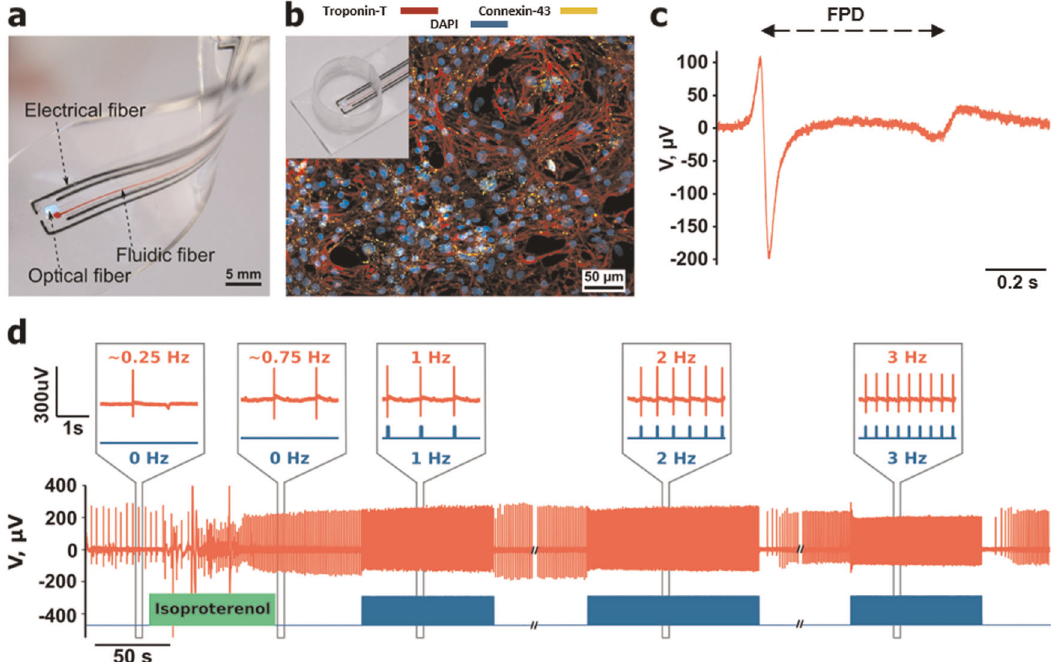
Fig. 4 Printed membrane for cardiomyocyte interfacing. a Integrated array of functional fi bres where active sites form four electrodes, an optrode and a chemotrode. b hiPSC-derived cardiomyocytes cultured on the array express key cardiomyocyte markers troponin-T (red) and connexin-43 (yellow). Nuclei are labelled with DAPI stain (blue). Scale bar 50 μ m. Inset: membrane equipped with printed culture chamber. c Recording of spontaneous electrical activity ( fi eld potential) from hiPSC-CM. The waveform shows clearly visible depolarization due to Na + in fl ux ( fi rst oscillation) and repolarization due to K + ef fl ux (smaller second oscillation). The fi eld potential duration (FPD) is 580 ms. The beat rate in this recording was approximately 0.15 Hz. d Bursts of optical pacing (blue) modulate the frequency of fi eld potentials (red) generated in the cardiomyocyte monolayer. Insets show individual fi eld potentials and their temporal relation to optical pulses. Infusion of isoproterenol increases baseline spontaneous activity. Additional pacing with optical bursts allows for further increase of fi eld potential frequency (representative